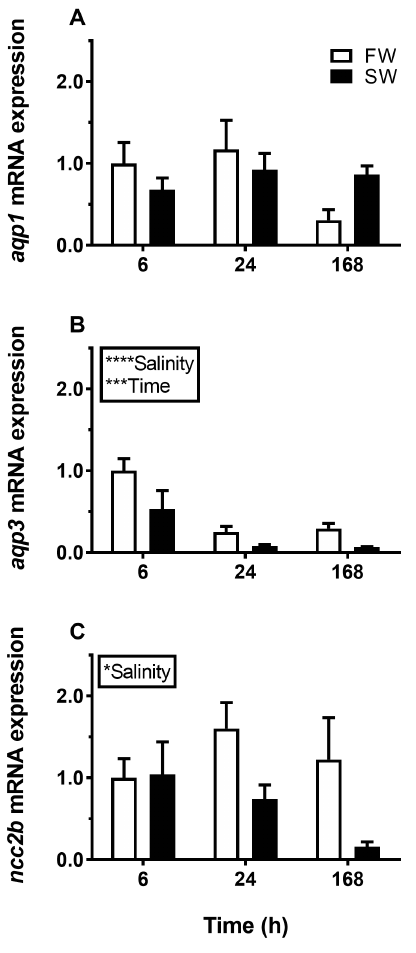
Figure 1. E ff ect of transfer from freshwater (FW) to (SW) on branchial aquaporin 1 ( AQP1) ( A ), AQP3 ( B ), and NCC2b ( C ) expression in medaka at 6, 24, and 168 h timepoints. FW–FW sham transfer (open bars), FW–SW transfer (solid bars). The level of each target was normalized to the geometric mean of the normalization genes EF1a , bact , and RPL7 and presented relative to the control group at 6 h. Data are presented as mean ± standard error of the mean (n = 7–8). Statistically significant factor e ff ects (two-way ANOVA, P < 0.05) are denoted by asterisks next to salinity or time (* P < 0.05, *** P < 0.001, **** P < 0.0001). No significant interaction between factors was found, and post-hoc tests were therefore